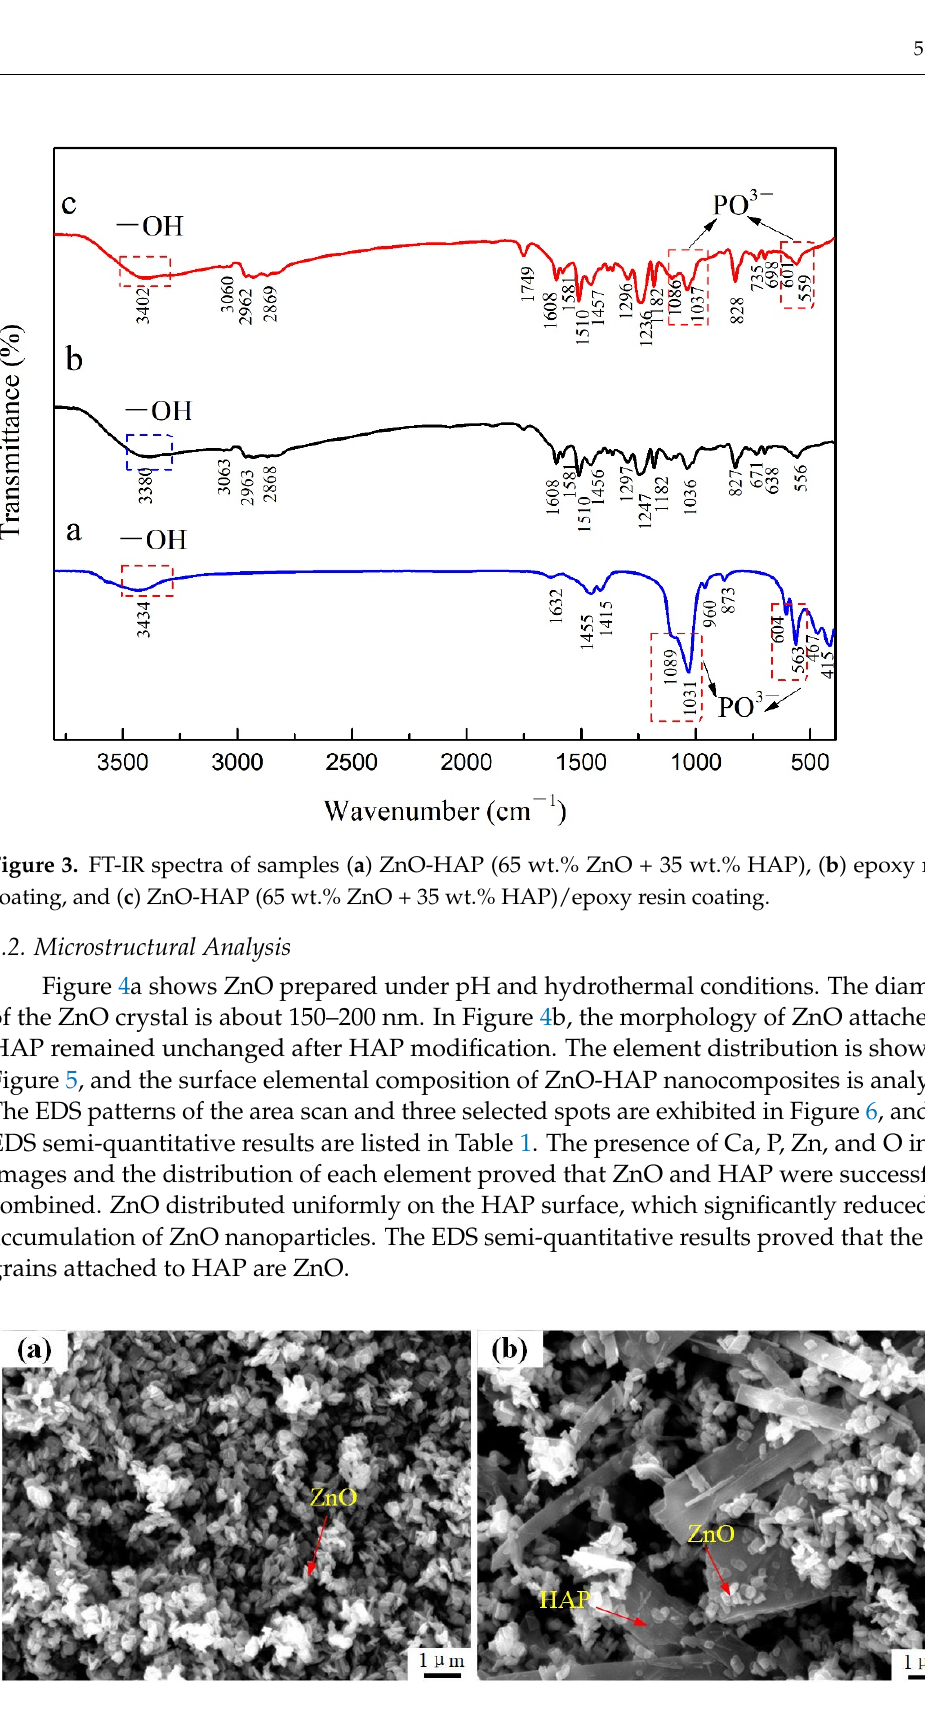
Figure 4. SEM images of ( a ) ZnO and ( b ) ZnO-HAP (65 wt.% ZnO + 35 wt.% HAP).